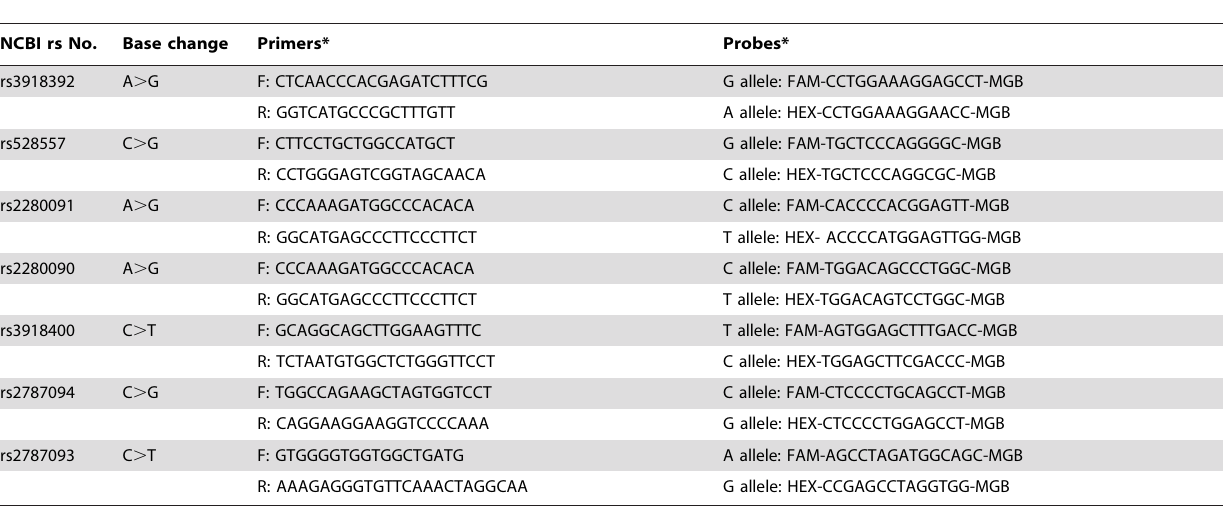
Table 1. Primers and probes for genotypes screening by TaqMan allelic discrimination.